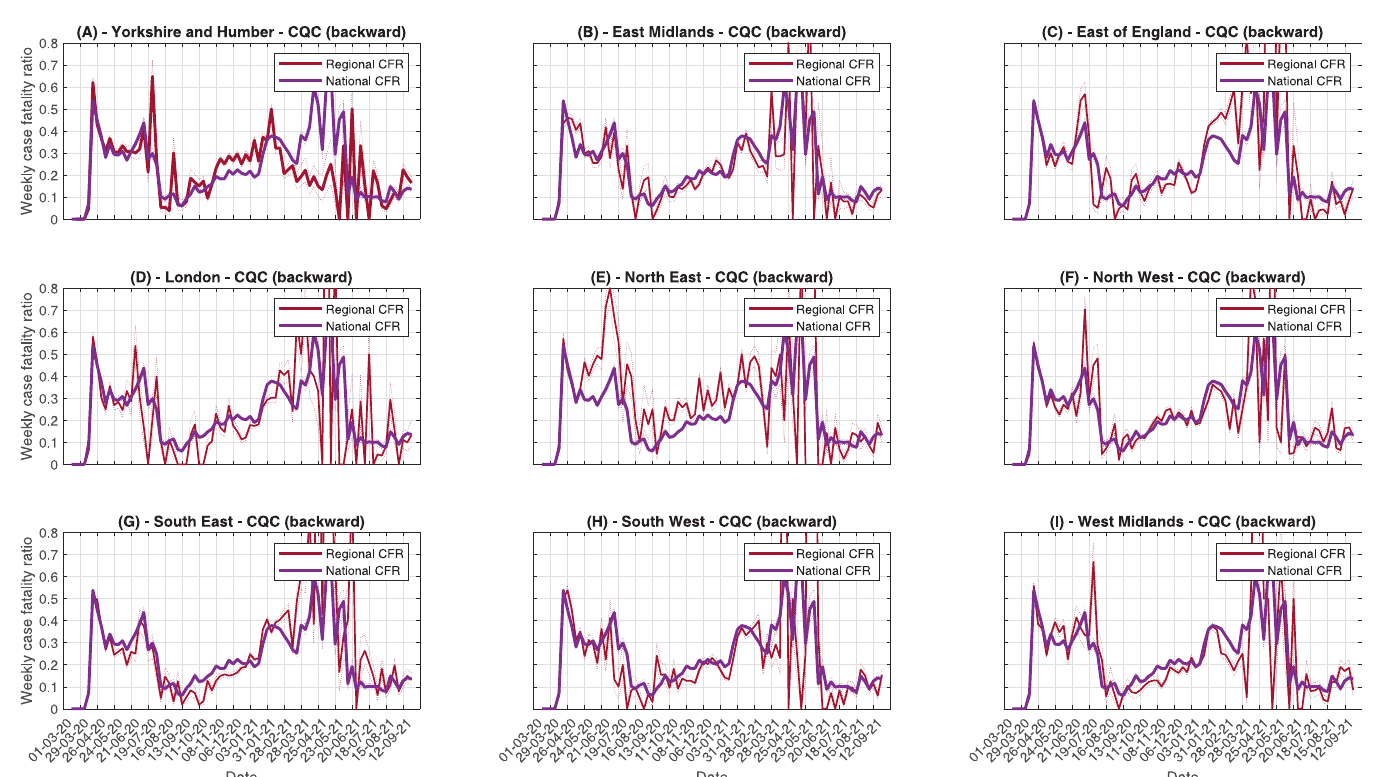
Fig 9. Comparing weekly CFR trends across English regions, using CQC data and the backward method. Each panel contains the regional trend and the national trend.